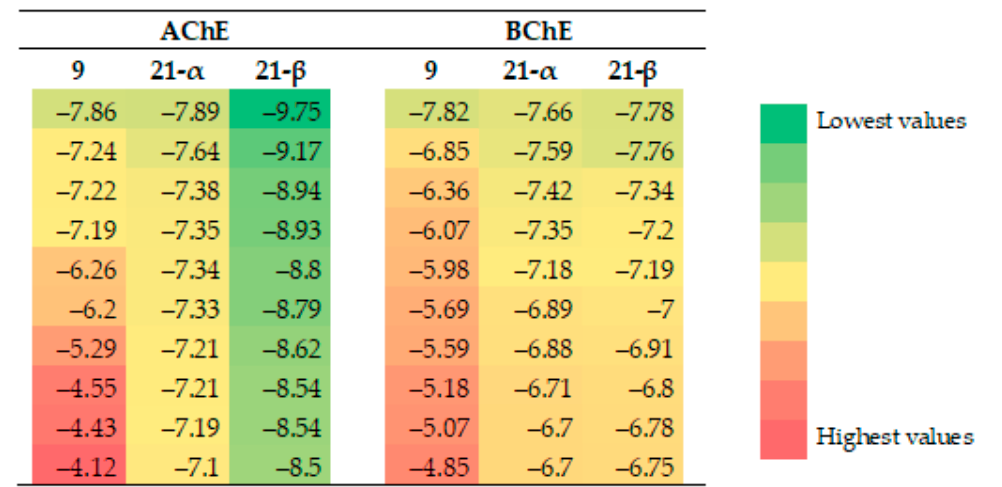
Figure 4. Binding energies (kcal/mol) of the top docking poses of compounds 9 , 21- α and 21- β into AChE and BChE.